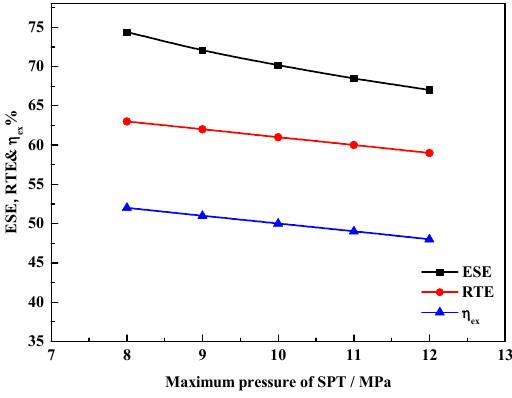
COM and operation time.